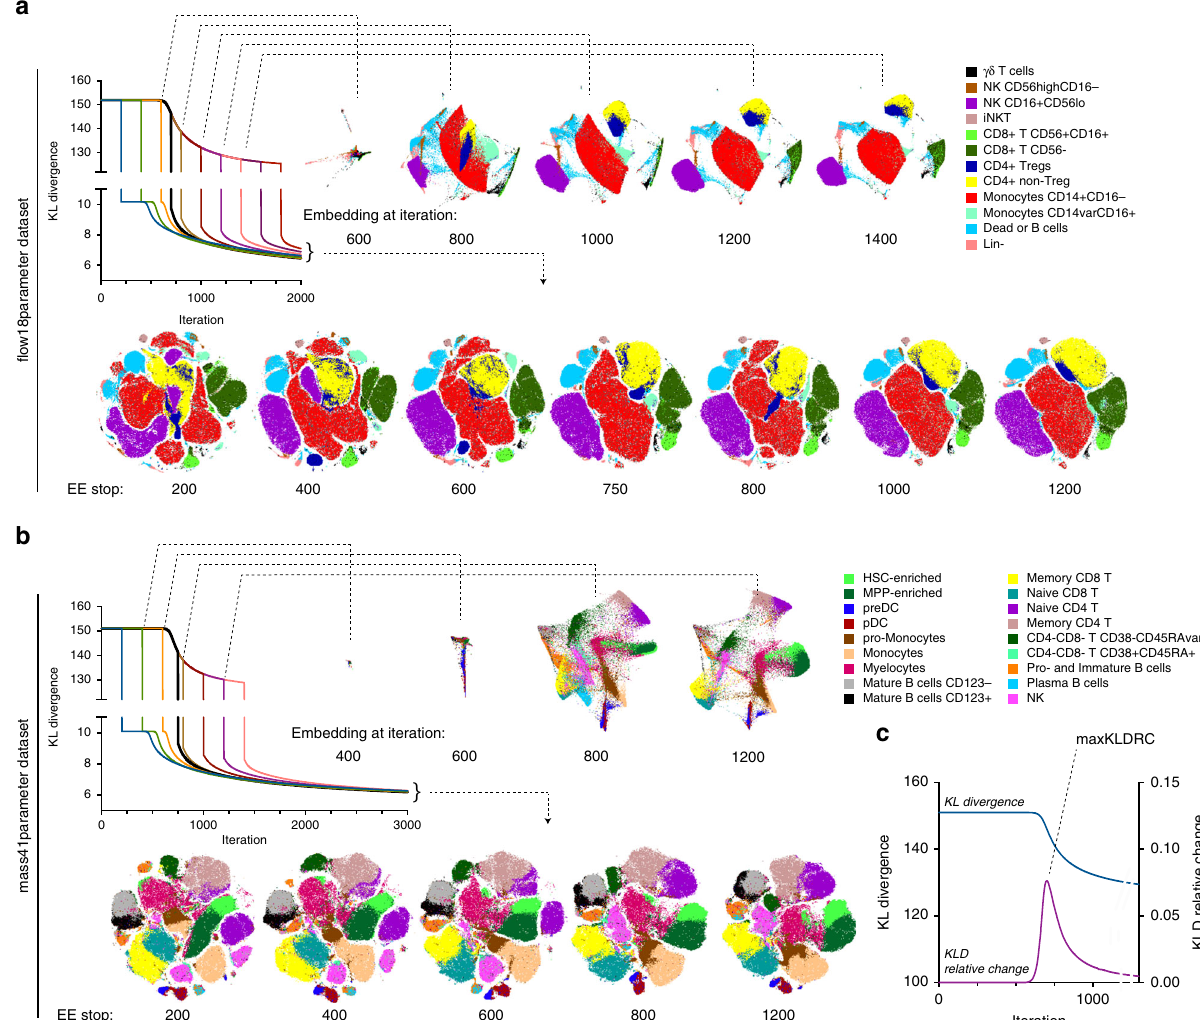
Fig. 2 Effect of EE plateau phase on t-SNE visualization. EE was stopped after varying number of iterations and embedding visualization was examined at several intermediate timepoints and in the end of embedding for fl ow cytometry (total of 2000 iterations), ( a ) and mass cytometry (total of 3000 iterations). b Graphs showing KLD change over iteration time are color-labeled to distinguish curves corresponding to experiment perturbations, with black line indicating the run with the shortest EE but uninterrupted plateau. t-SNE maps are annotated with color-coded population overlays based on ground- truth classi fi cation of single cell in the datasets. c KLD and KLD relative change plotted against iteration time for the mass41parameter embedding. All embeddings were generated with standard BH-tSNE implementation and representative examples of multiple runs with varying seed values are